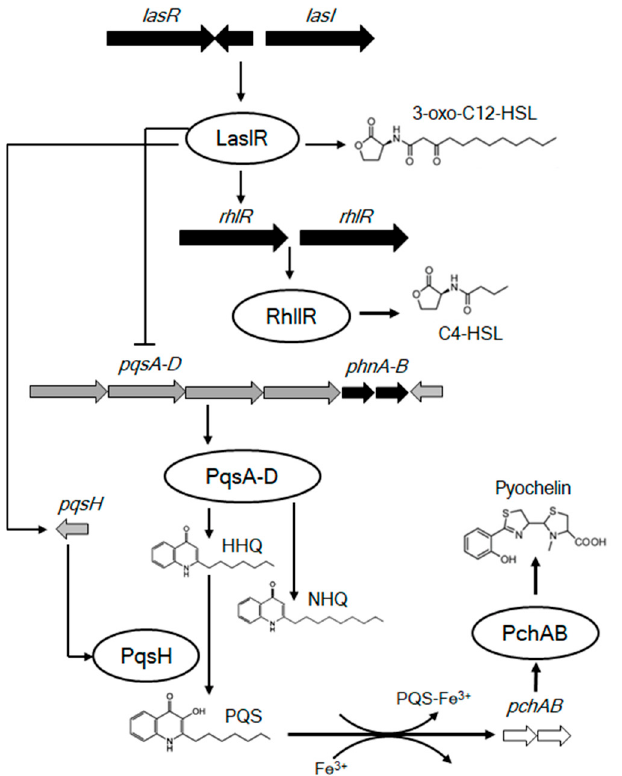
Figure 4. The hierarchical N -acyl-homoserine lactone quorum sensing system in P. putida 6157 biofilm. LasI-LasR contains genes that produced 3-oxo-C12-HSL. While the RhlI-RhlR system generates C4-HSL. AHL-QS are linked as LasR/3-oxo-C12-HSL is required for full expression of pqsH , which controls the production of PQS. The pqs group is repressed by the action of the RhlR/C4-HSL system. HHQ and NHQ are produced via PqsA-D system itself. Furthermore, PQS released from the cell is capable of binding iron (PQS-Fe 3+ complex). The removal of iron by PQS induces expression of genes involved in siderophore production, leading to pyochelin production.